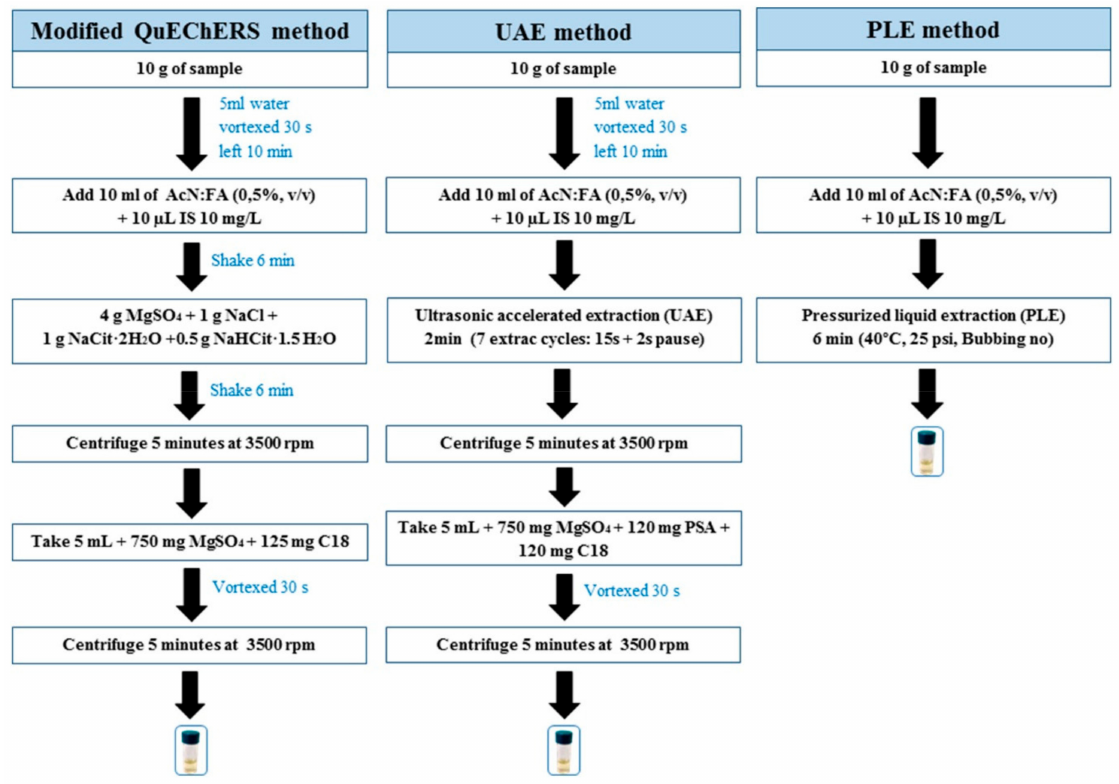
Figure 4. Diagram of the three methods used for the agricultural soil sample extraction. Reprinted from [51] with permission from